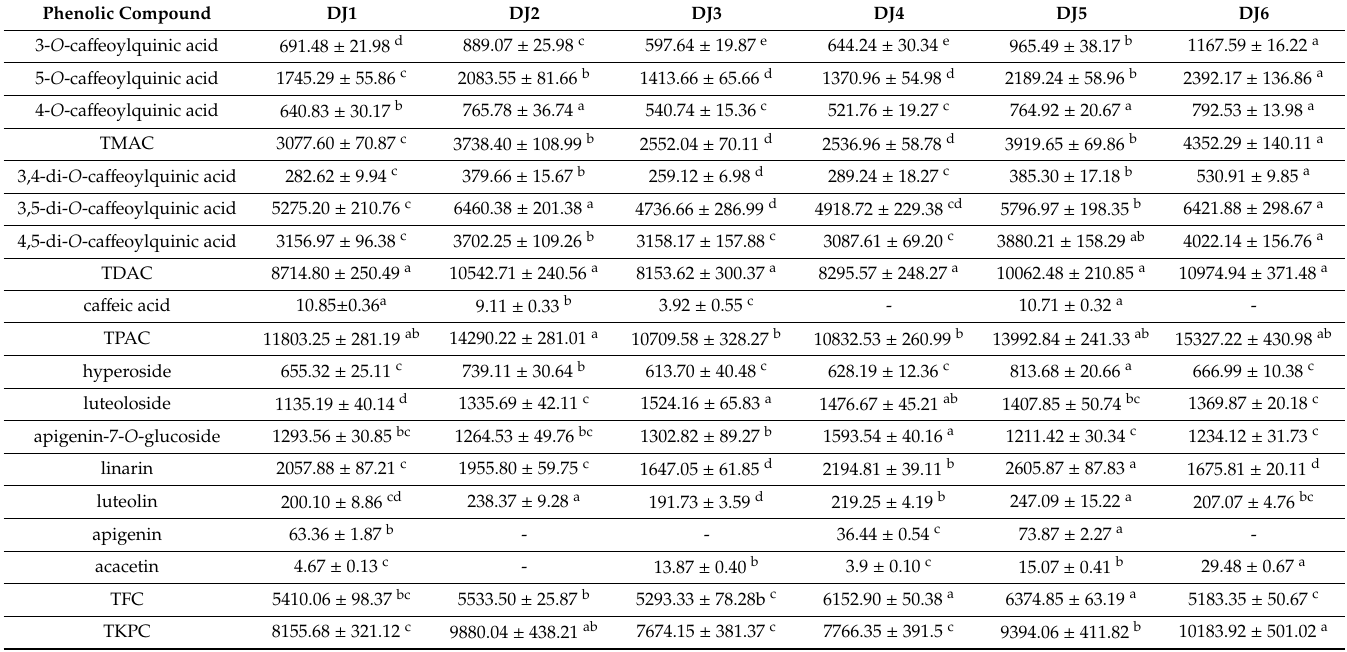
Table 1. Contents of phenolic compounds in di ff erent ‘Duoju’ ( µ g / g